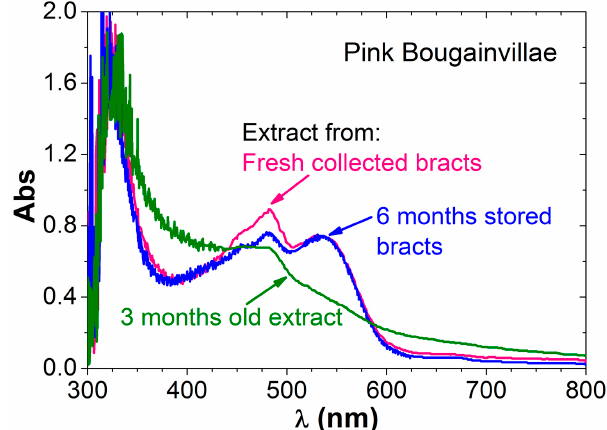
Figure 9. UV-Vis spectra of pink bougainvillea extract 3 months after preparation (green line). UV-Vis spectra of recently prepared dye extracts made from (i) bracts just after been collected (red data) and (ii) bracts preserved for 6 months (blue data).